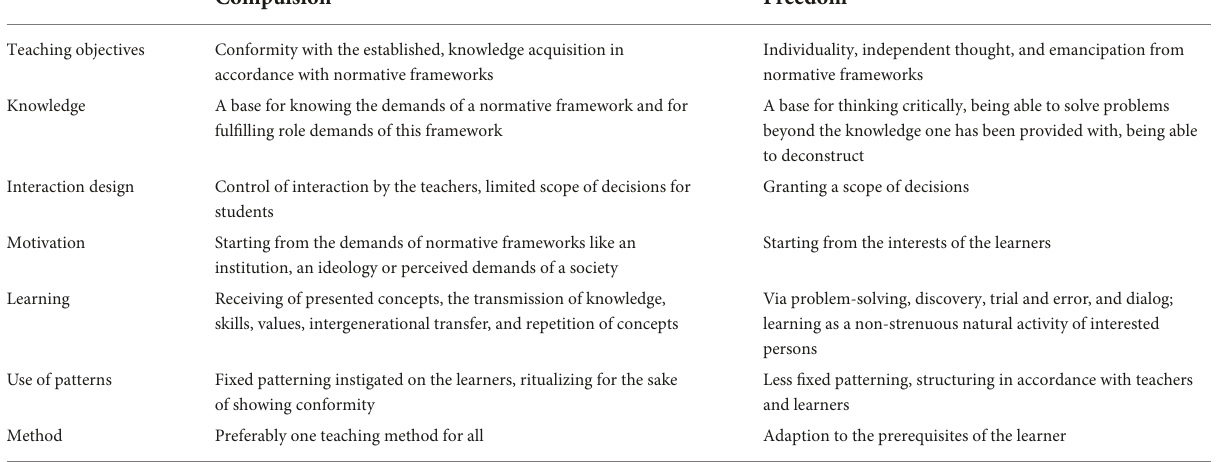
TABLE 1 Dimensions of compulsion and